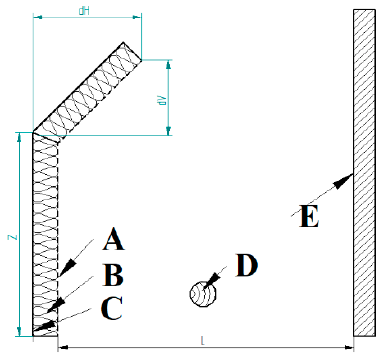
Figure 3. Barrier design and location (barrier components: A —perforated metallic sheet, B —porous material, C —unperforated sheet; D —the supply ramp modelled as a point source, E —commercial centre wall, L —distance between barrier and commercial wall) .